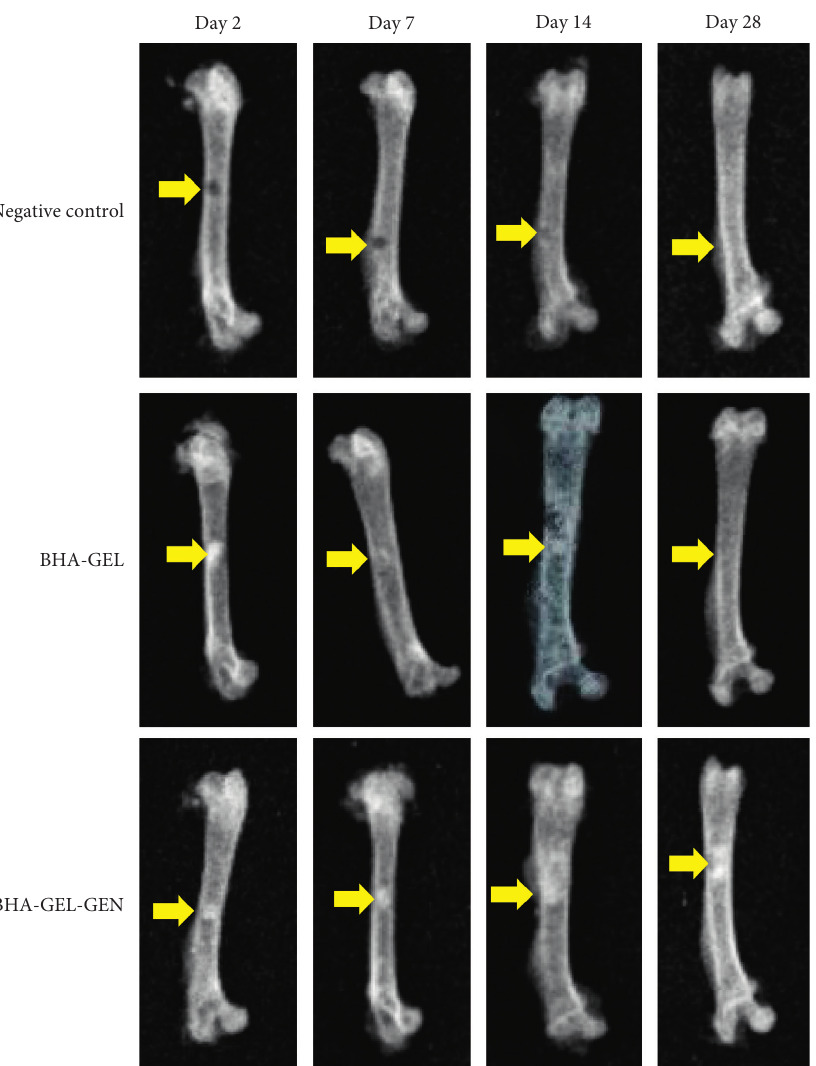
Figure 1: Radiograph of rat femur. The yellow arrow indicates the location of the defect. The implanted group showed accelerated bone growth in the defect